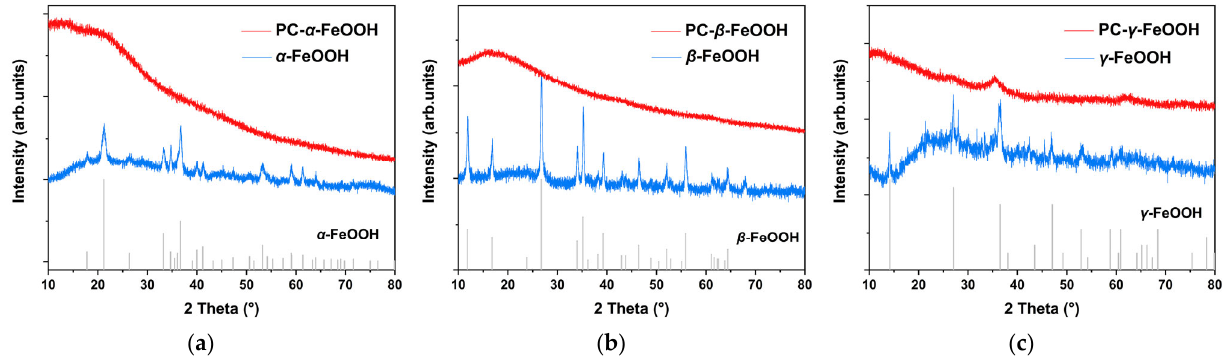
Figure 8 . XRD of α‐ FeOOH ( a ), β‐ FeOOH ( b ), γ‐ FeOOH ( c ) modified by proanthocyanidins. Figure 8. XRD of α -FeOOH ( a ), β -FeOOH ( b ), γ -FeOOH ( c ) modified by